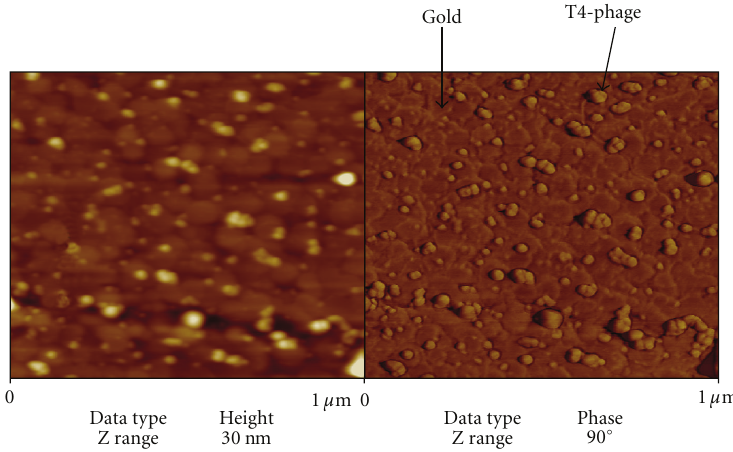
Figure 3: AFM images of T4-phage deposited on gold surface.